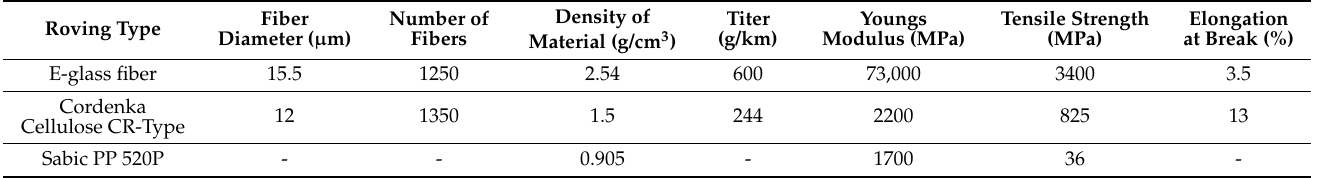
Table 1. Properties and parameters of used material [10,22].